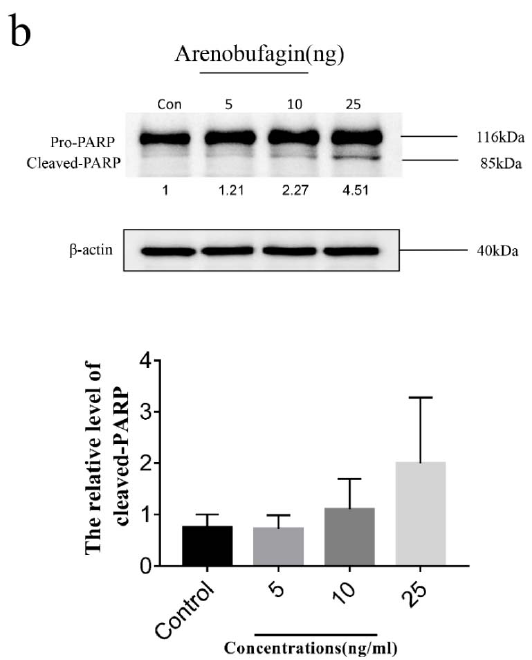
Figure 8. Arenobufagin induces apoptosis in A549 cells. A549 cells were incubated with arenobufagin for 48 h. ( a ) The e ff ects of arenobufagin on apoptosis were analyzed by flow cytometry. ( b ) Detecting the protein expression levels of PARP by Western blotting.